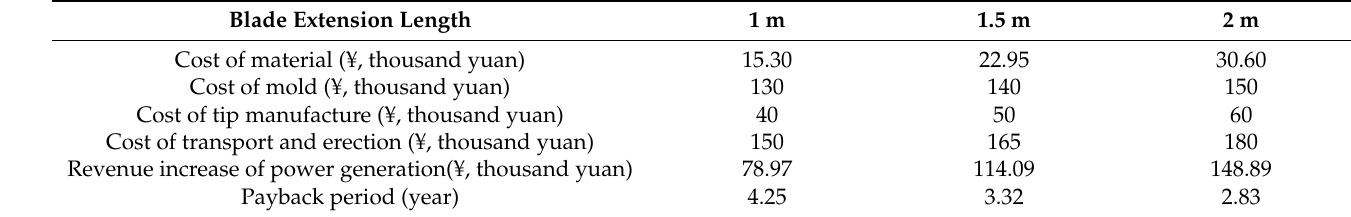
Table 18. The cost of wind turbines after blade